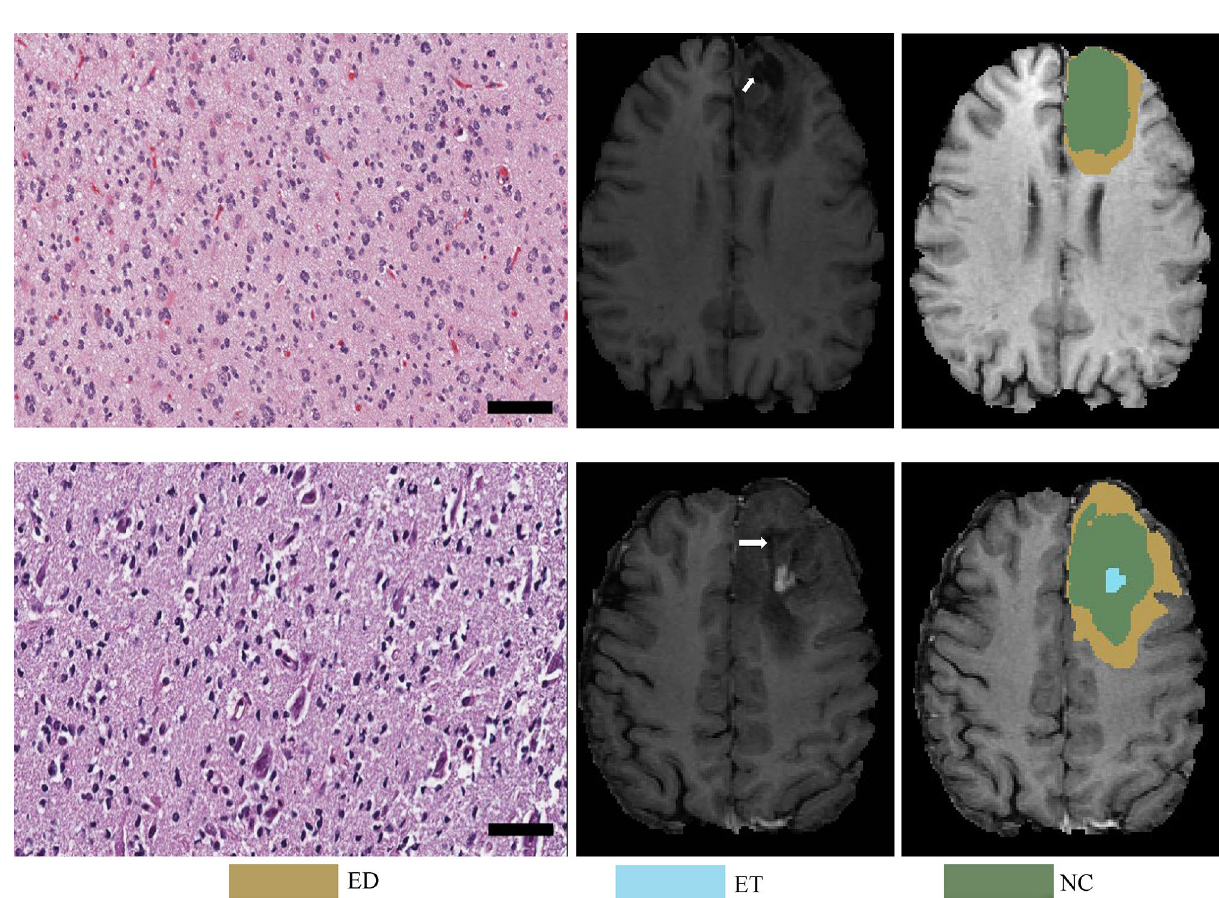
Figure 10. Two cases of misinterpretation from Oligodendroglioma to Astrocytoma. From left to right: WSI, corresponding T1ce and its segmentation. (Top): Case of CPM20_TCIA10_239_1, (Bottom): Case of CPM20_ TCIA1_387_1. The arrow on T1ce points to